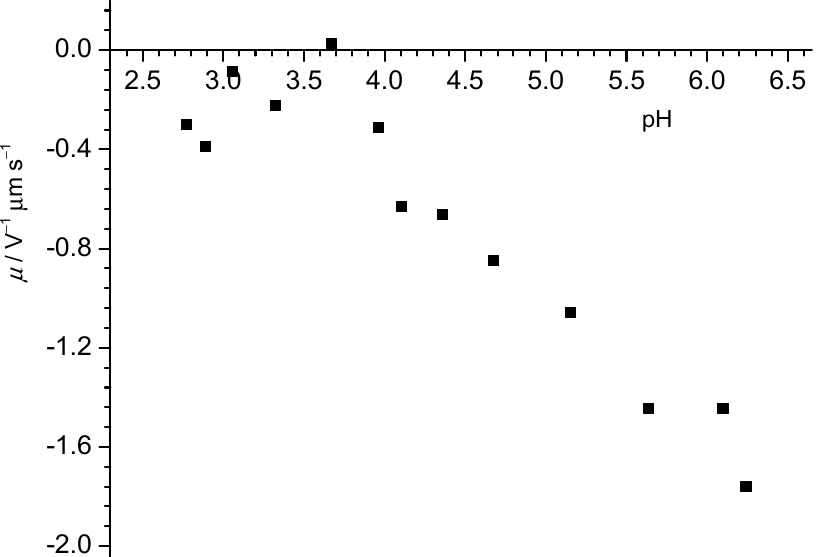
Figure 7. Electrophoretic mobilities of hydrophobic silica particles in I c = 1 mmol dm − 3 aqueous sodium chloride solution at 25 °C.